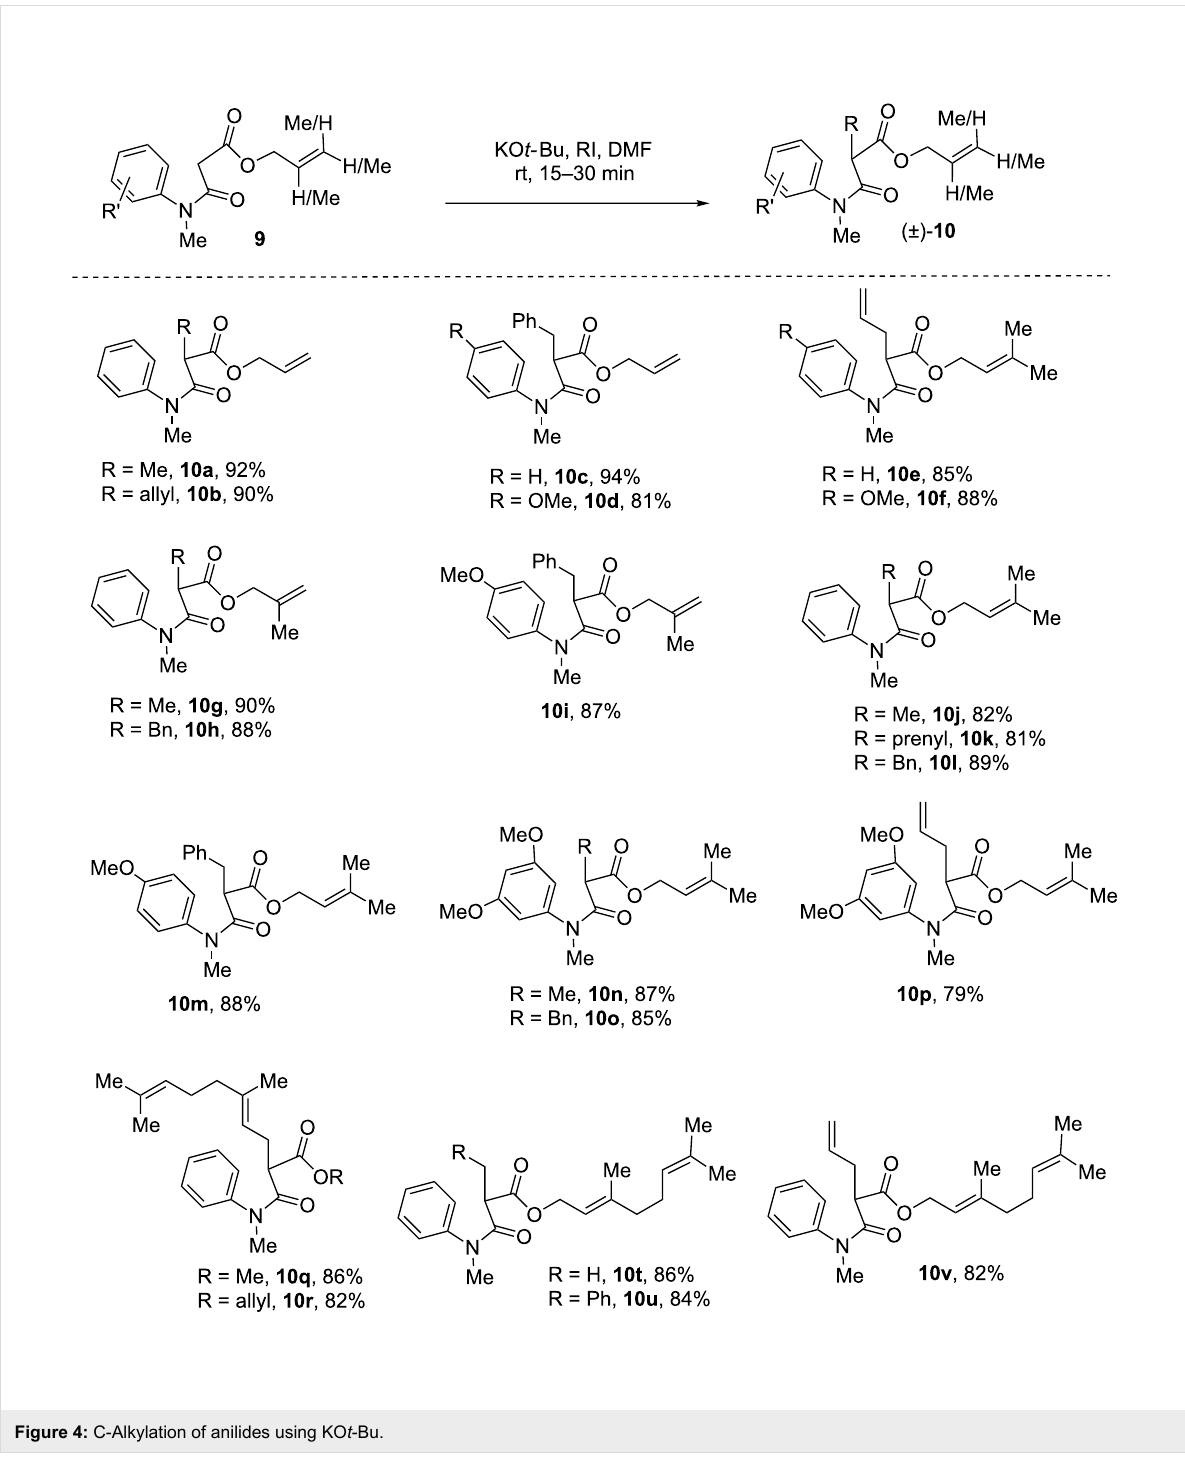
2-oxindoles sharing vicinal all-carbon quaternary centers from dimeric β - N -arylamidoesters 18a and b (Scheme 4). The reason behind our interest towards this direction was due to the preva- lence of various dimeric cyclotryptamine alkaloids containing 3a,3a'-bis-pyrrolo[2,3- b ]indole subunits (core structure of alka-